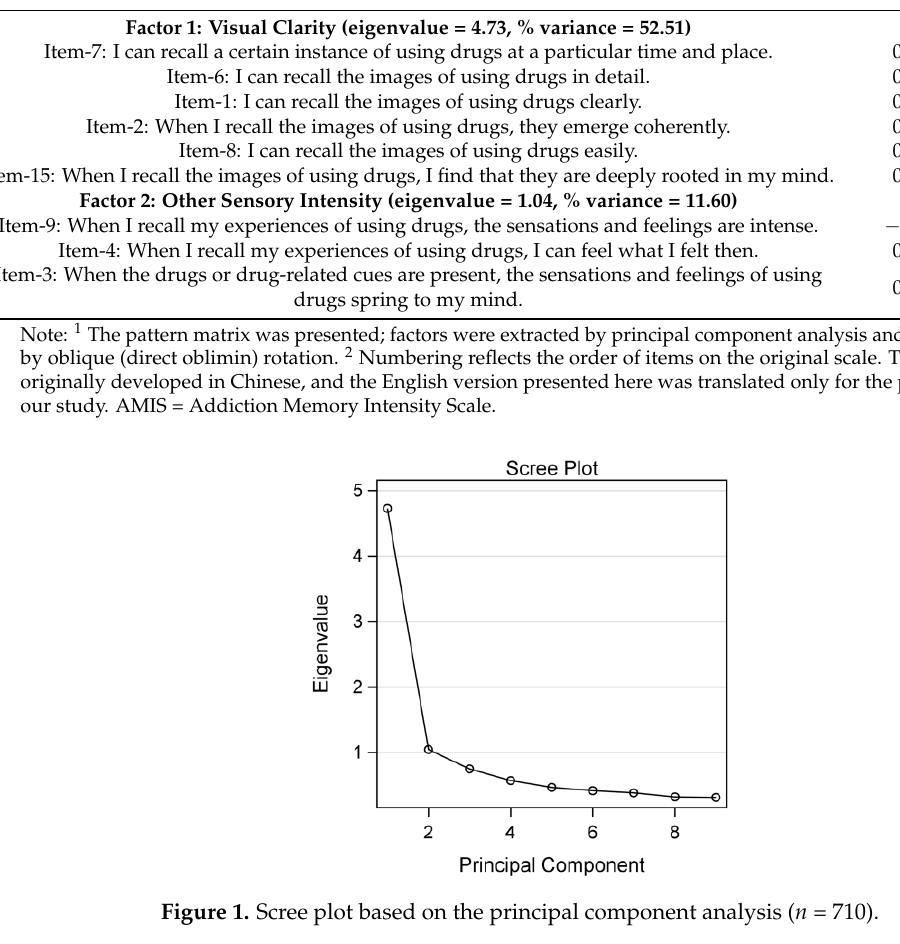
Table 3. Exploratory factor analysis of the Addiction Memory Intensity Scale (AMIS; n = 710) 1 . Items of the AMIS 2 Factor 1 Factor 2